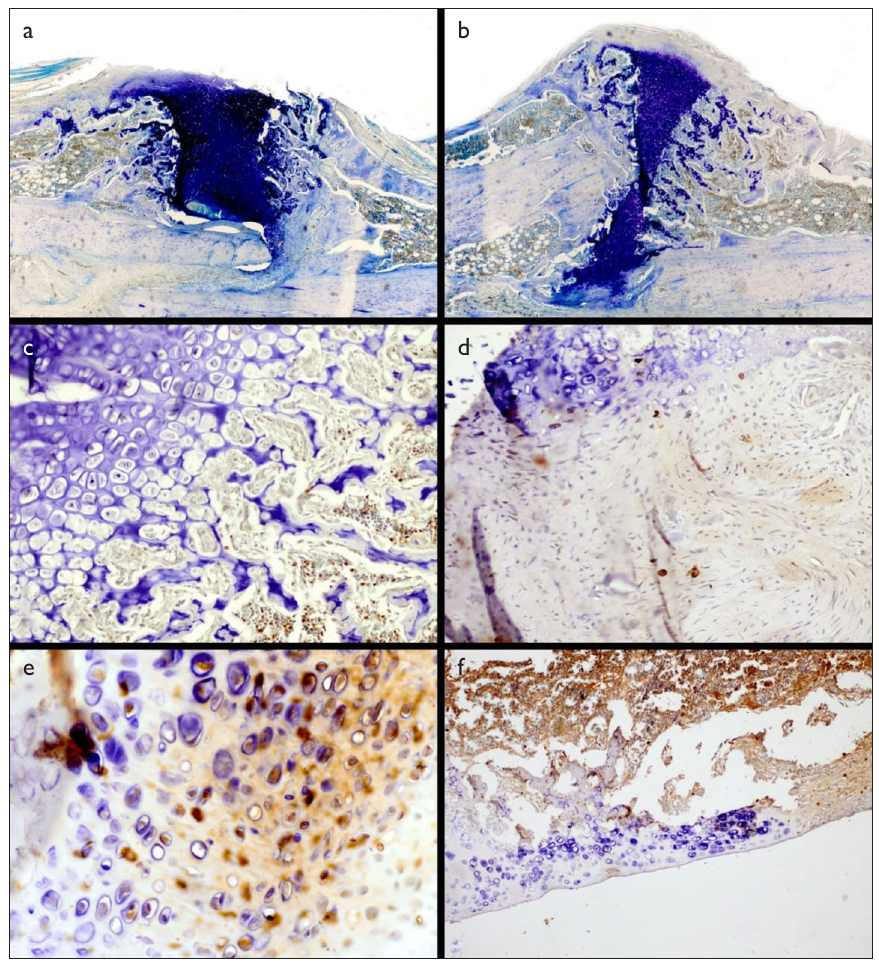
Figure 4. a-f. a) No treatment group. Toluidine blue. Magnification is 100X. b) Ebselen treatment group histology. Toluidine blue. Magnification is 100X. c) Immunohistochemistry shows the VEGF labeling in